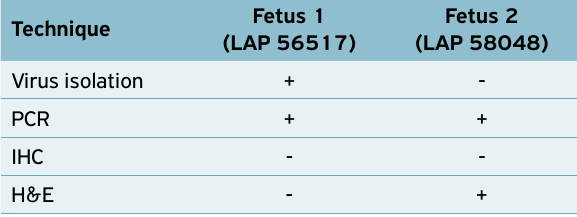
Table 1. Diagnosis of equine herpesvirus 1 in two fetuses by virus isolation, polymerase chain reaction, immunohistochemistry, and histology (haematoxylin and eosin — H&E).